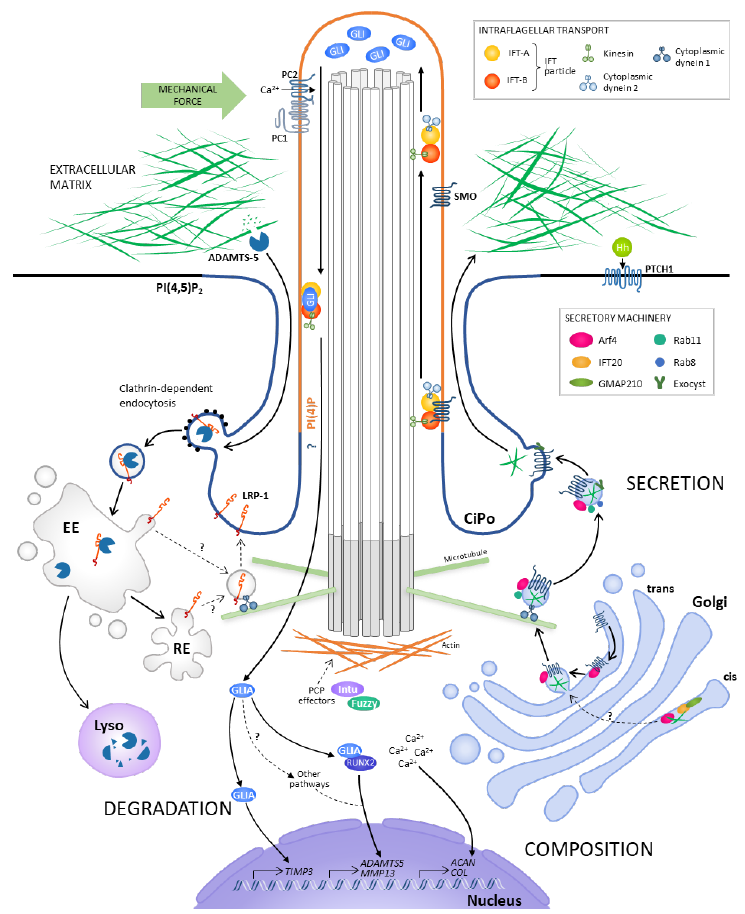
Figure 1. Hypothesised regulation of extracellular matrix composition by the cilium and ciliary proteins. Matrix-degrading proteases such as ADAMTS-5 bind to the LRP-1 receptor, which is polarised at the periciliary region in chondrocytes, possibly at the endocytosis-active structure, the ciliary pocket (CiPo). These enzymes are tra ffi cked through the endosomal pathway to the lysosome (Lyso), where they are degraded. Recycling of the LRP-1 receptor to the ciliary / CiPo membrane may occur directly from the early endosome (EE) or via the recycling endosome (RE). Ciliary proteins have also been shown to regulate proteases at transcriptional level. The transcriptional e ff ectors of the Hh pathway (GLIs), directly target genes encoding protease-regulating proteins such as TIMP-3, or interact with other transcription factors such as RUNX2 to regulate the expression of the protease itself. The Hh pathway could also interact with other pathways to regulate this process. Transcription of matrix components that determine the composition of the ECM occurs downstream of a calcium response triggered by the action of mechanosensitive receptors on the ciliary membrane, such as the polycystins PC1 and PC2. Proteins involved in intraflagellar transport (IFT), which mediates the tra ffi cking of cargo from the cell body to the tip of the cilium and back via motor protein-driven IFT particles, have been linked to matrix secretion. IFT20 localises to the cis -Golgi, where it is anchored by the protein GMAP210, and could be involved in the targeting of proteins to the cilium via Arf4-driven tra ffi cking and subsequent exocyst-mediated exocytosis. Exocytic and endocytic vesicles in the cytosol are transported by motor proteins along microtubules, which emanate from the main microtubule organising centre (MTOC) of the cell, the centrosome, at the base of the cilium. The mechanism by which IFT20 mediates this ciliary targeting, how it interacts with Arf4, and the extent of polarisation of matrix secretion at the cilium, are unknown. Positioning of the basal body at the plasma membrane, and therefore of the cilium and cellular processes that occur in the periciliary region, is influenced by the planar cell polarity (PCP pathway). PCP e ff ectors such as Inturned and Fuzzy regulate the actin cytoskeleton, which in turn controls basal body